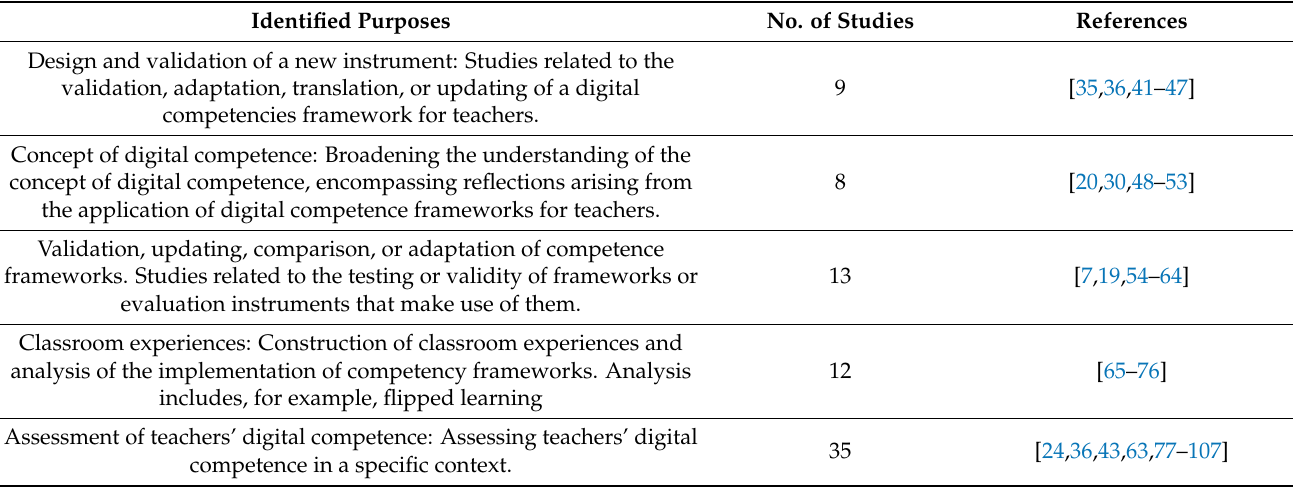
Table 7. Ranking of the purposes of the 77 studies analyzed.